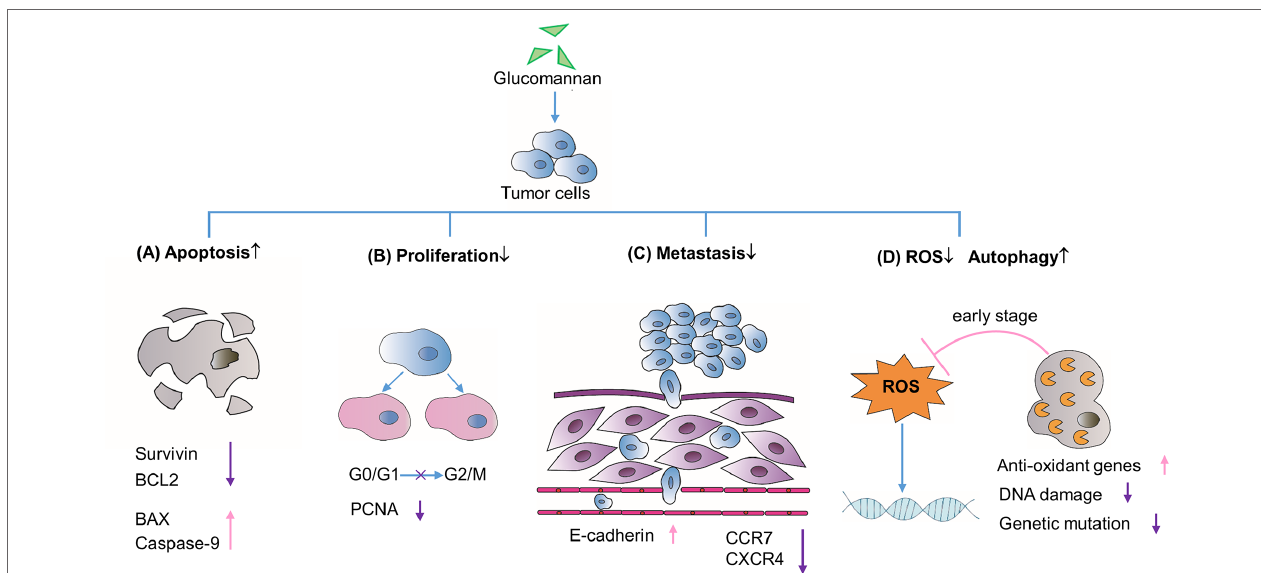
FIGURE 1 | Direct effects on tumor cell biological processes. (A) Glucomannan promotes tumor cell apoptosis through the up-regulation of pro-apoptotic proteins BAX and Caspase-9 and the down-regulation of anti-apoptotic genes like Survivin and BCL2. (B) Glucomannan inhibits tumor cell proliferation through the blockade of G0/G1 to G2/M phase transition and decreases the expression of PCNA. (C) Glucomannan hinders tumor cell metastasis by decreasing CCR7 and CXCR4 expression and increasing E-cadherin level. (D) Glucomannan promotes autophagy and reduces ROS production in tumor cells, thus leading to the alleviation of DNA damage and subsequent mutation